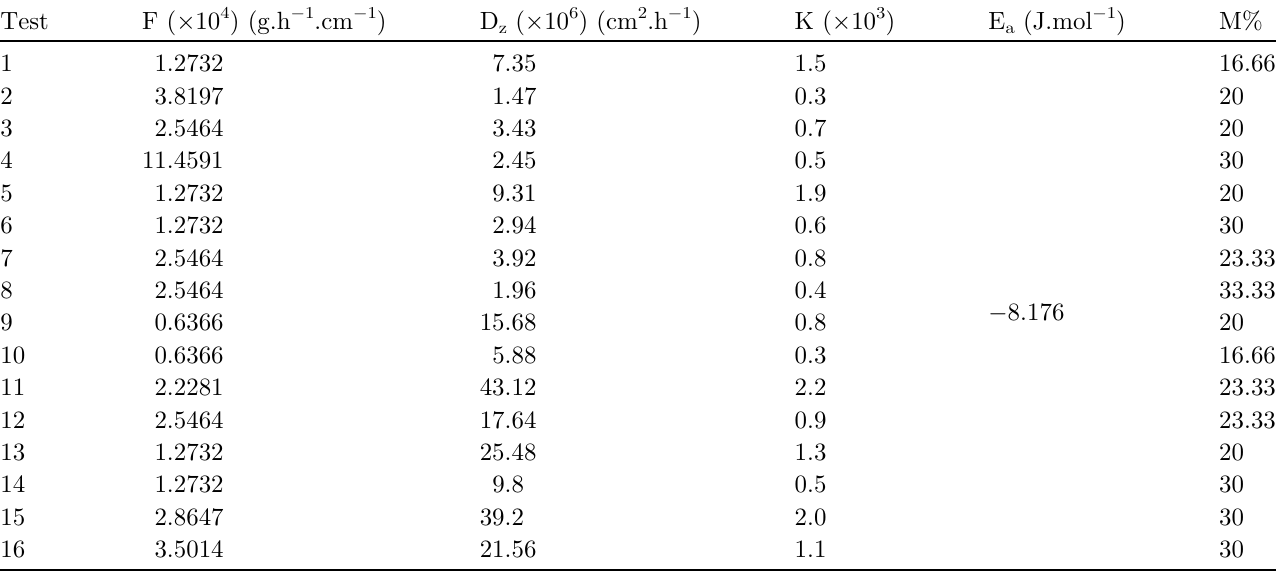
Table 8. Parameters of diffusion and of insecticidal activity of EOCa desorption in the RC. Test